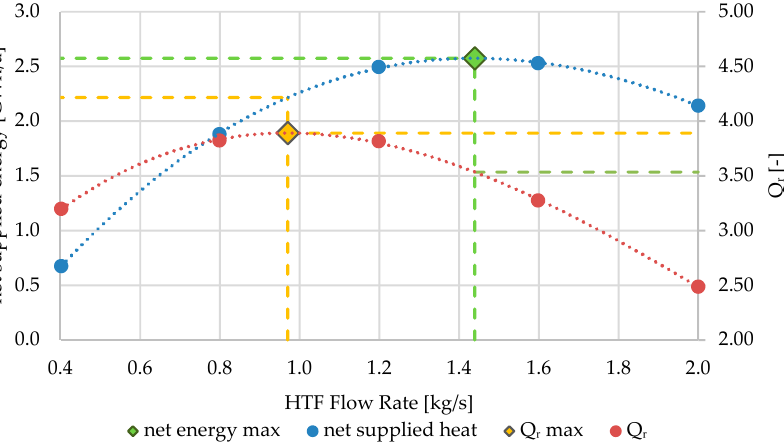
Figure 28. Modeled flow rates vs. net supplied energy for 42 boreholes charged at 60 ◦ C. A summary of modeled flow rates for different combinations of configurations and charging temperatures is shown in Figure 29. The bar plot represents the thermal output Q out , sys of the storage system and the dotted lines the thermal ratio ( Q r ) . for each configuration and charging temperature. The color codes differentiate between the flow rate for maximum energy (blue) and the flow rate for maximum thermal ratio (green). which maximized the thermal ratio (green). The flow rate maximizing energy output for each combination of configuration and charging temperature was modeled for a 10-cycle period. Figure 30 below shows the thermal efficiency (Equation (2)) of each configuration by number of boreholes and charging temperature (left y -axis) and system COP (right y